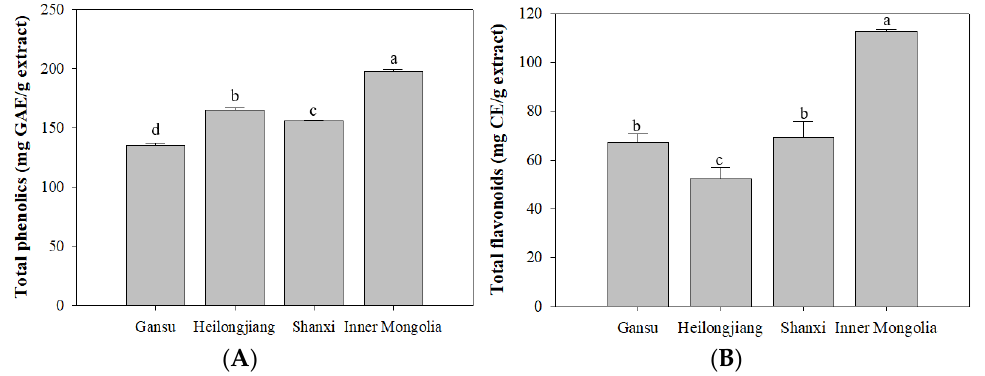
Figure 1. Total phenolics and total flavonoids contents of A. membranaceus roots from different origins (Gansu, Inner Mongolia, Shanxi, and Heilongjiang). ( A ), total phenolics contents; ( B ), total flavonoids contents. Values in one column with different letters are significantly different ( p < 0.05).